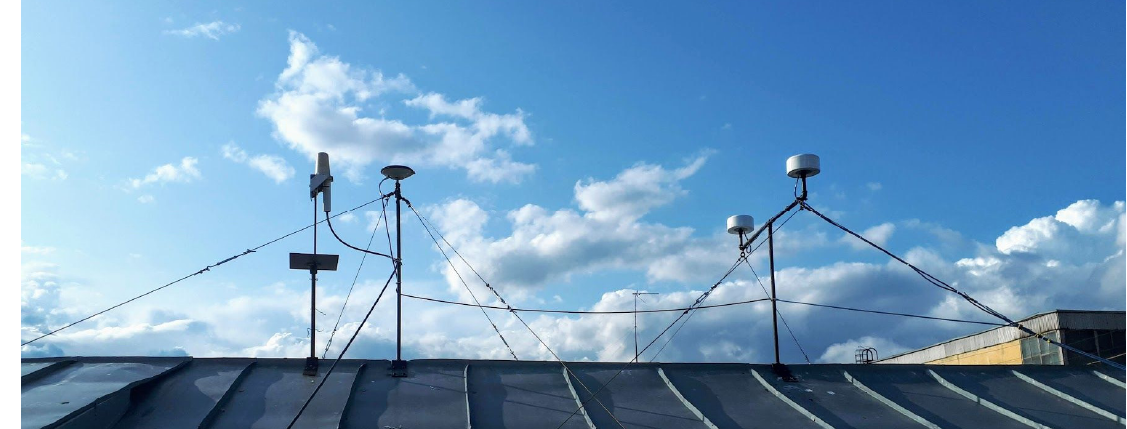
Figure 4. MAI GNSS laboratory antennas installed on the roof of a building.